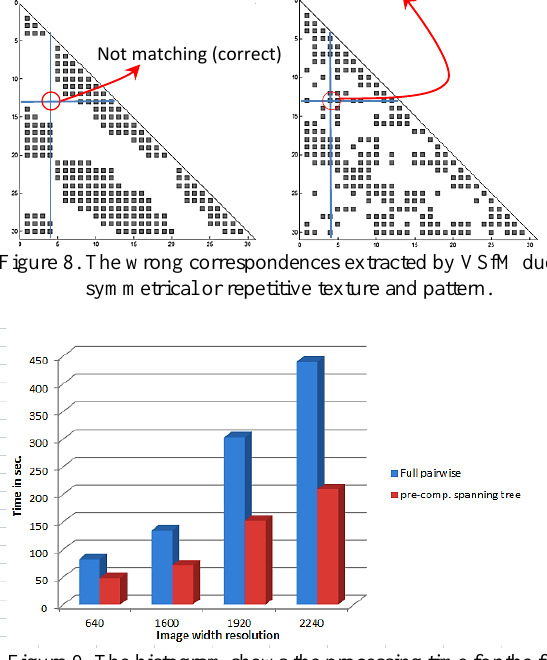
Figure 9. The histogram shows the processing time for the full pairwise and the developed spanning tree.